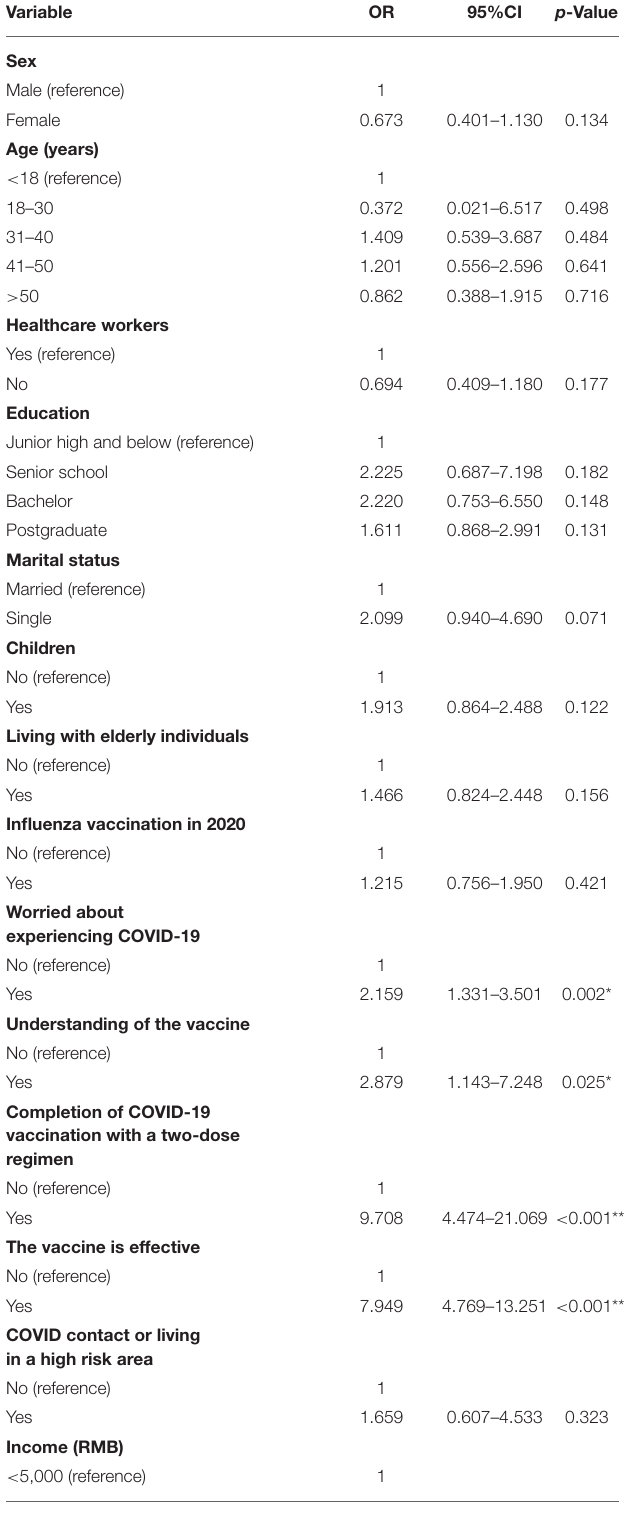
TABLE 2 | The multivariate logistic regression analyses showing the factors associated with acceptance of a booster dose ( n = 1,062).